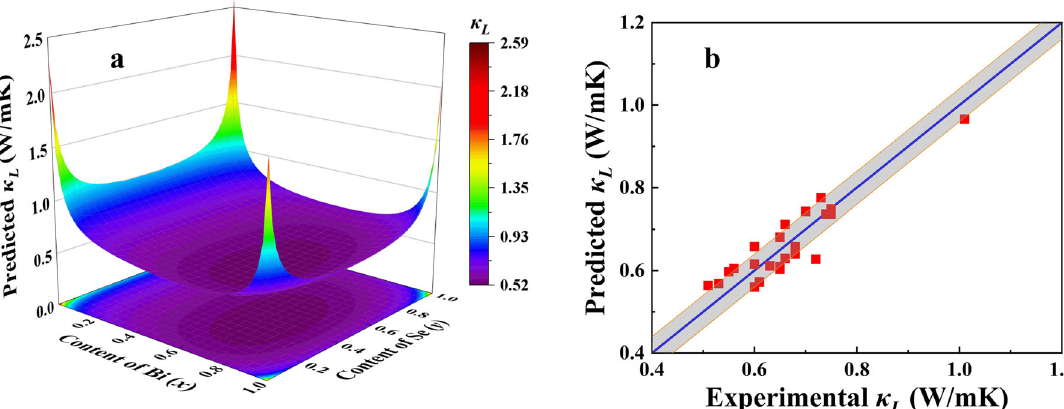
ð Se Þ , plotted as a y Te 1 (cid:2) y 2 3